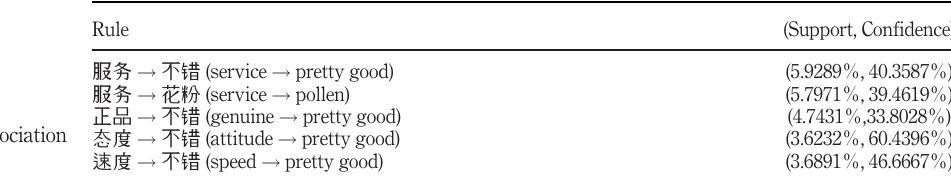
Table II. (Portion) association